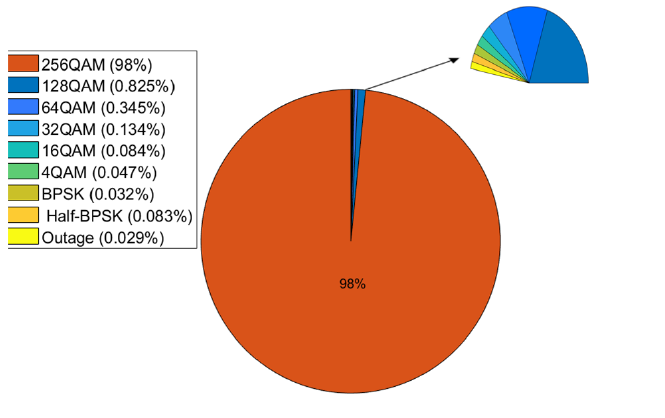
Figure 5. Adaptive modulation modes for full-duplex wireless back-haul E-band link along 1.8 km.